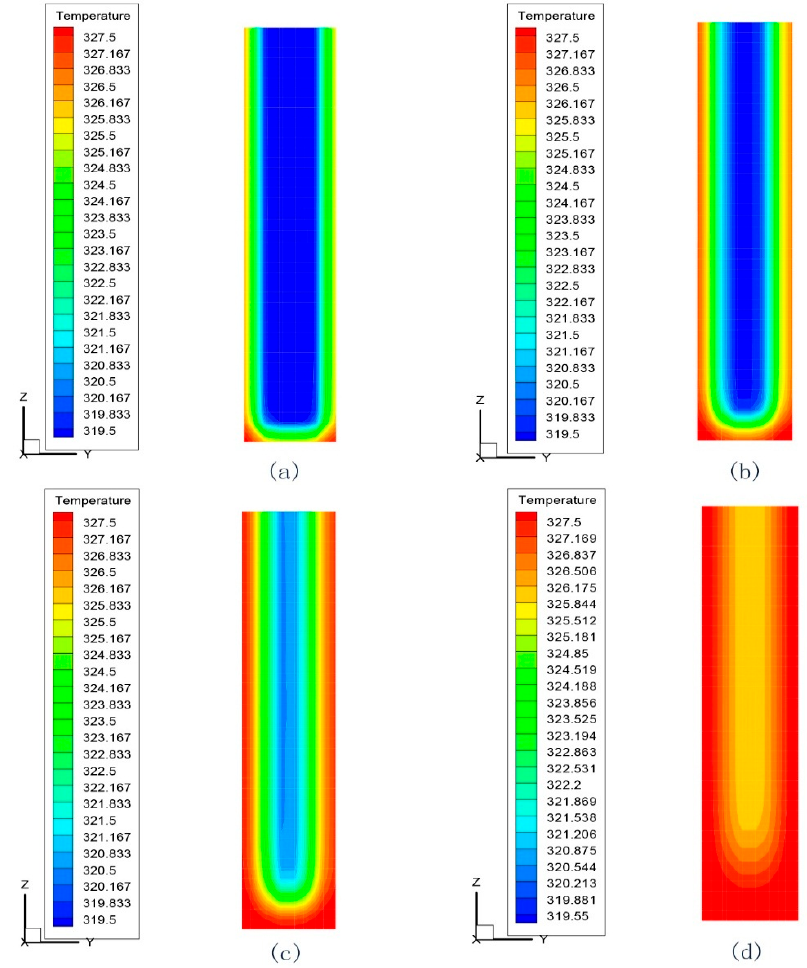
Figure 7. Simulated melting process of PCM cylinder modules (diameter is 40 mm, water temperature is 55 °C): ( a ) 17 min; ( b ) 34 min; ( c ) 51 min; ( d ) 68 min .